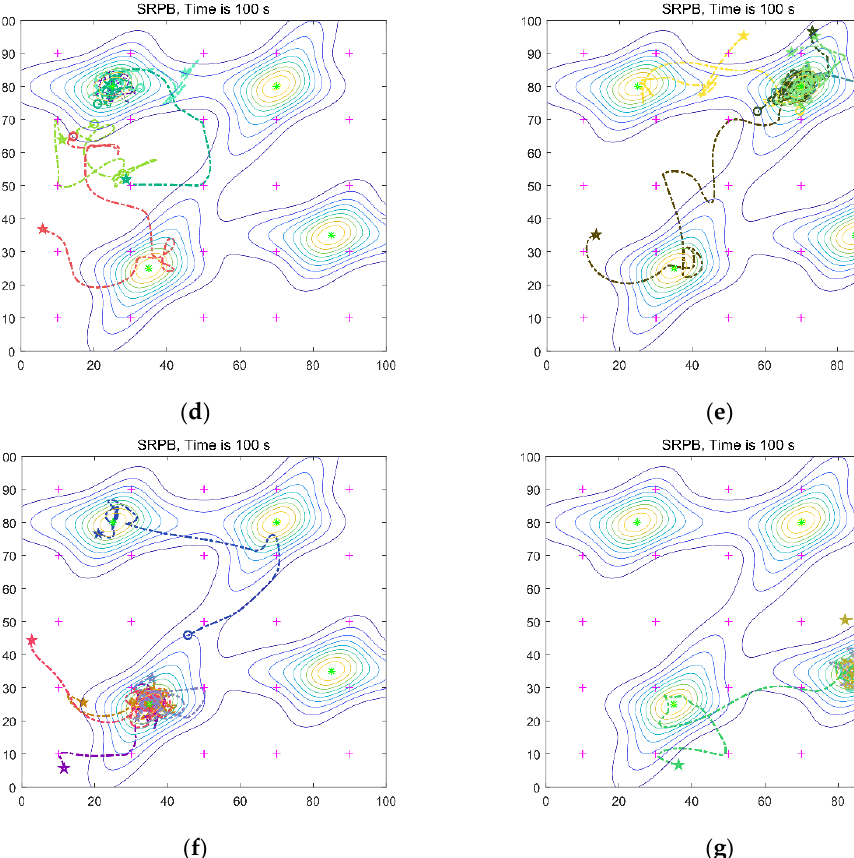
Figure 8. Twenty robots seek four sources of the anisotropic signal. ( a ) robots’ trajectories from initial locations to the extrema; ( b ) initial of robots; ( c ) final location; ( d ) robots move to the first target; ( e ) robots move to the second target; ( f ) robots move to the third target; ( g ) robots move to the last target.